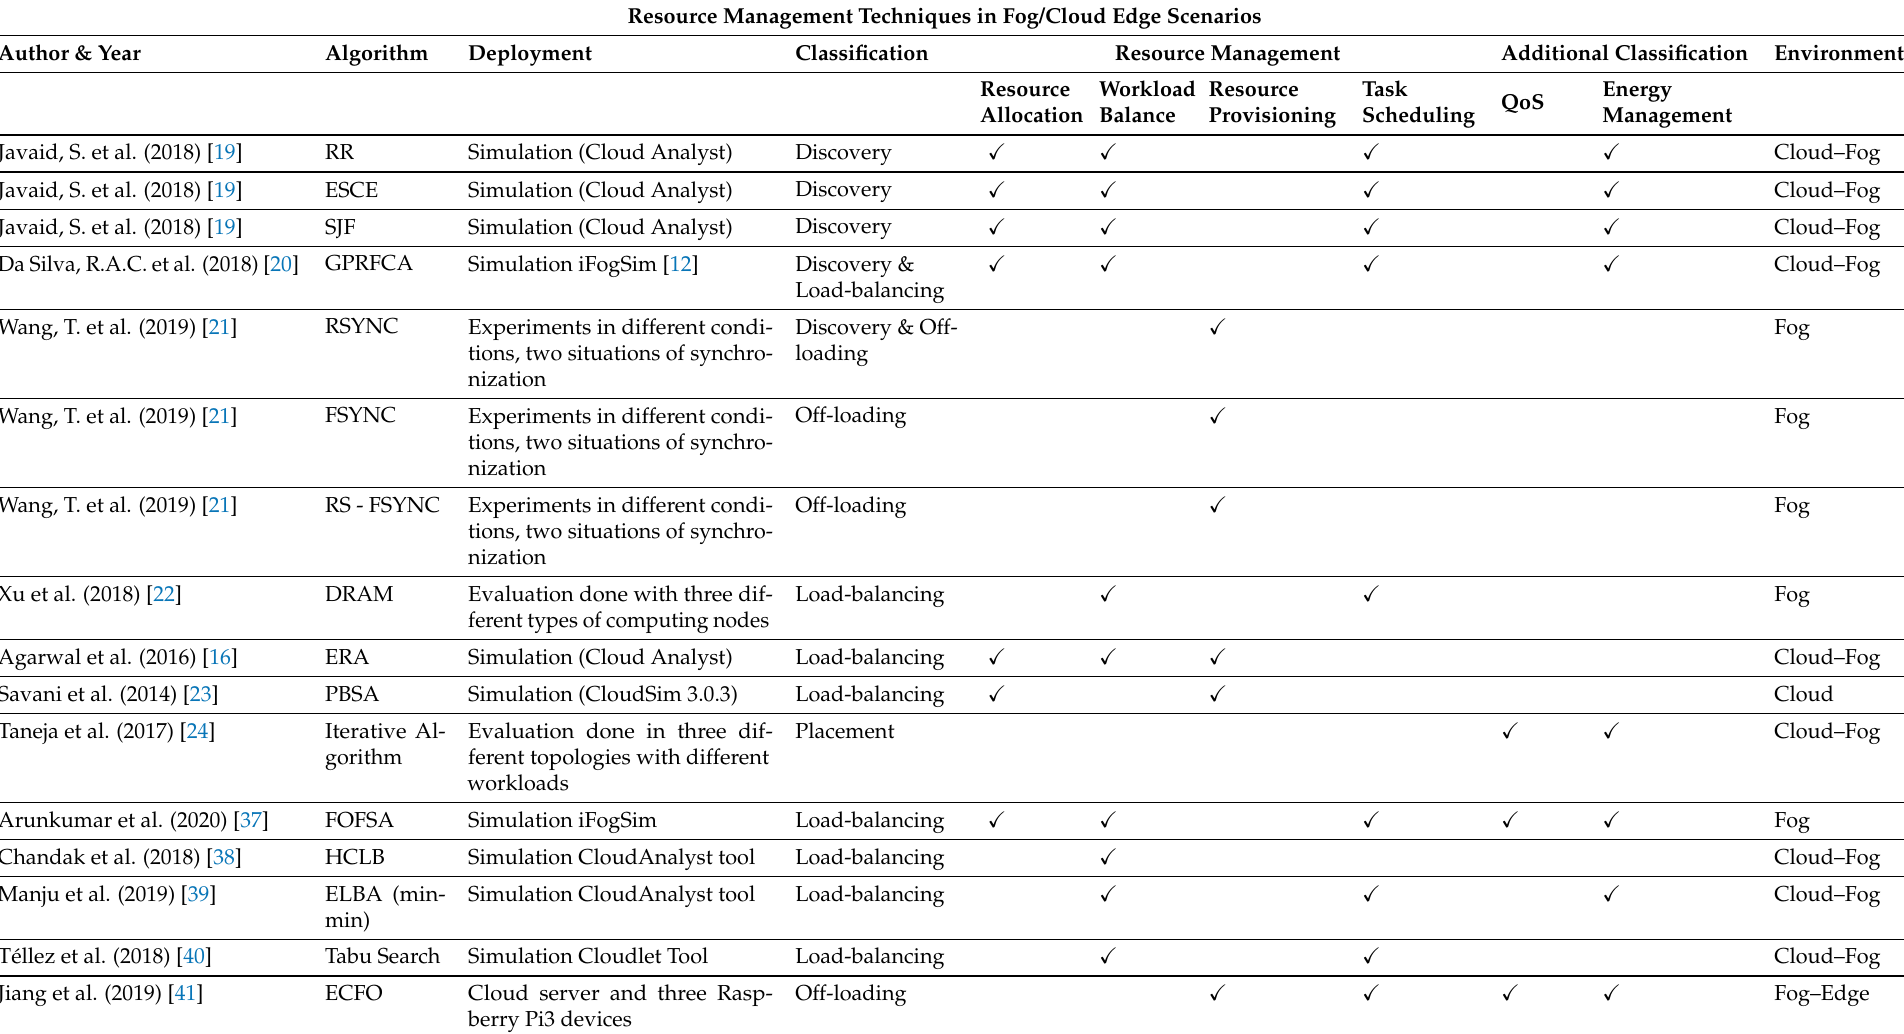
Table 2. Evaluation framework for applied algorithms in fog–cloud and edge